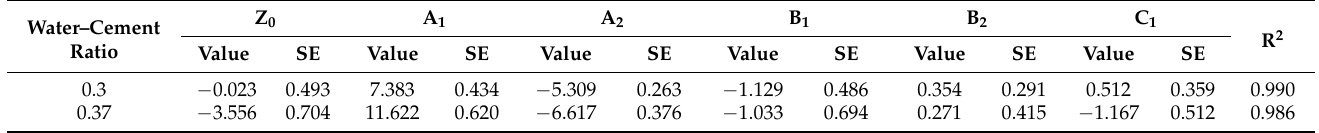
Figure 10. The relationship between SAP particle size, content, and splitting tensile strength: ( a ) water–cement ratio of 0.3; ( b ) water–cement ratio of 0.37. Table 7. Prediction equation fitting of concrete in splitting tensile strength.